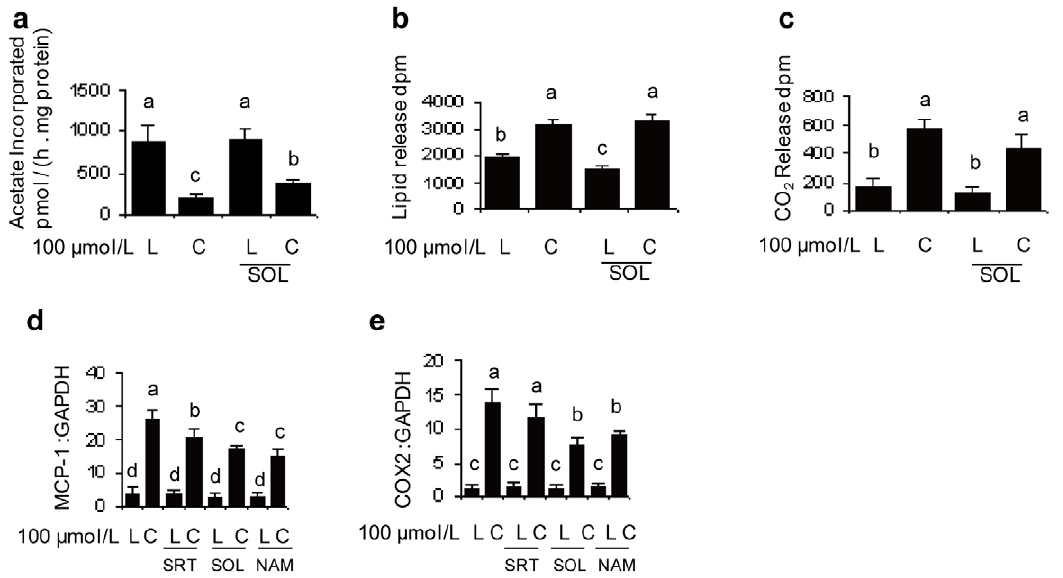
Figure 2. SIRT1 affects fatty acid metabolism and inflammatory mRNA levels. a–c The effects of 100 m mol/L of t 10 c 12 CLA, with or without the sirtuin inhibitor sirtinol (SOL), on the rates of fatty acid metabolism were measured by radioactive tracers (disintegrations per minute: dpm) as follows: a fatty acid biosynthesis by incorporation of [1- 14 C]-acetate; b lipolysis by the release of lipids previously labeled with [1- 14 C]-acetate; c fatty acid oxidation by the release of [ 14 C]-CO 2 from lipids previously labeled with [1- 14 C]-oleate. d–e The effects of the SIRT1 activator SRT1720 (SRT), or the sirtuin inhibitors sirtinol (SOL) or nicotinamide (NAM) on RNA levels in LA or t 10 c 12 CLA treated adipocytes were analyzed for MCP-1 and COX2 relative to GAPDH by reverse transcription and quantitative PCR. The relative amounts of MCP-1 and COX2 mRNA are shown as bar graphs. Each bar in panels a–e represents the mean + SEM (n=3 for a–b or n=2 for c–e ), and is representative of three independent experiments. Means not sharing a common letter differ, P ƒ 0.05.